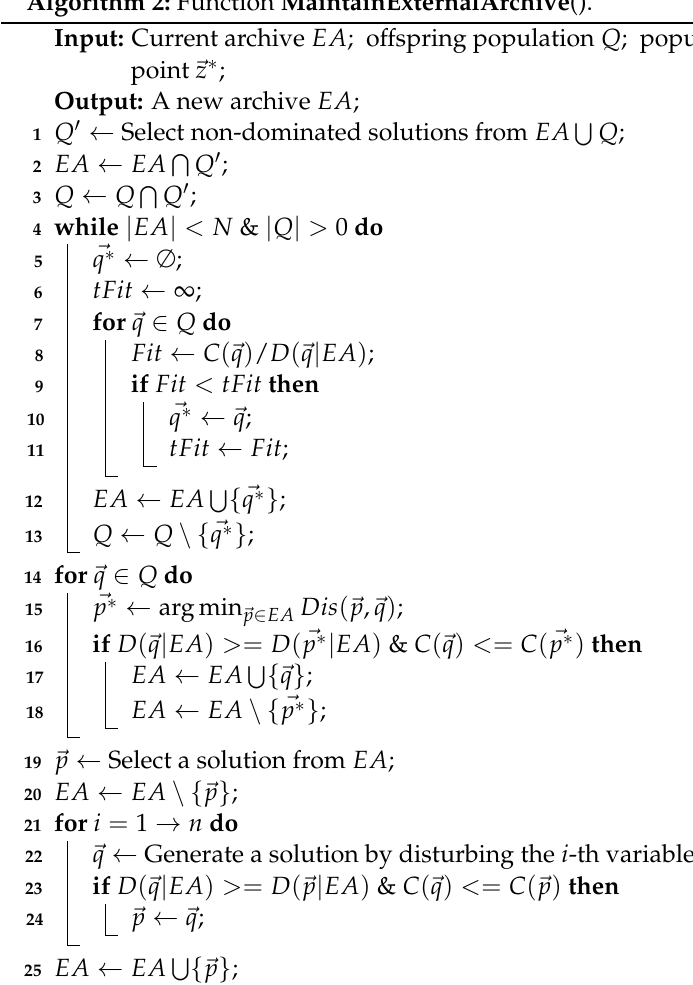
Algorithm 2: Function MaintainExternalArchive